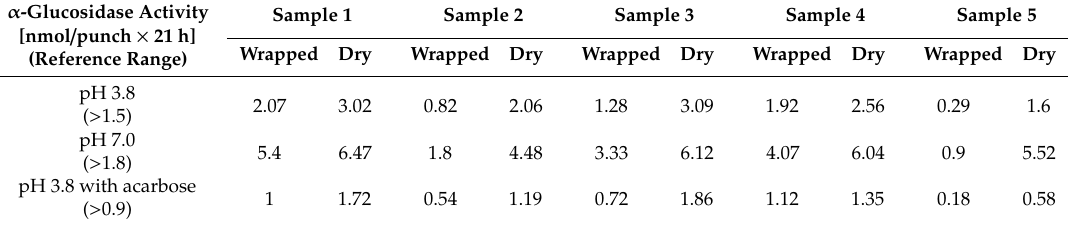
Table 4. Degradation study of GAA activities for five dried blood specimens that showed di ff erent index activities. Samples were either dried overnight after spotting (dry) or put into sealed plastic bags immediately, in order to simulate shipping without proper drying (wrapped). After 2 days the samples were taken out and allowed to dry overnight. Both specimens were tested in the same run in duplicates. All samples showed a significant decrease in activity when the specimen was not dried before